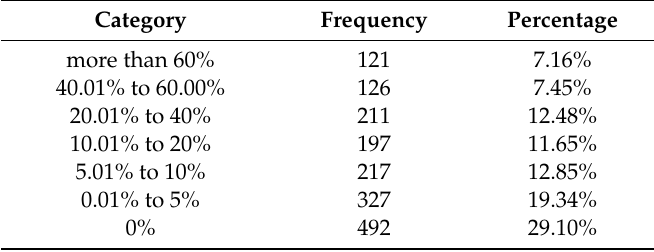
Table 1. Percentage of work-related dreams (retrospective estimates; N = 1691).